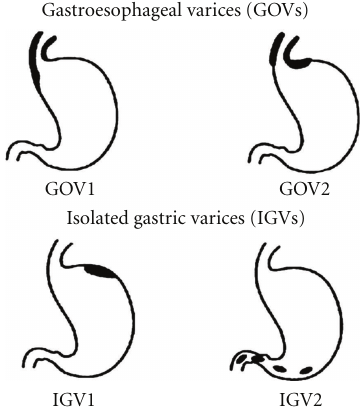
Figure 1: Sarin Classification of gastric varices (adapted from Sarin et al.